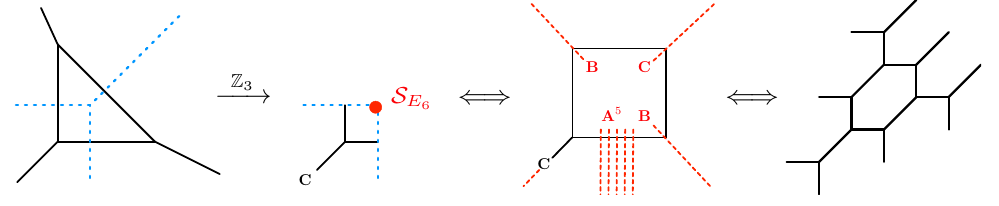
Figure 11 . The Z 3 quotient of the 5d SCFT of a local P 2 (the E 0 theory), leading to SU(2) + 5 F or T 3